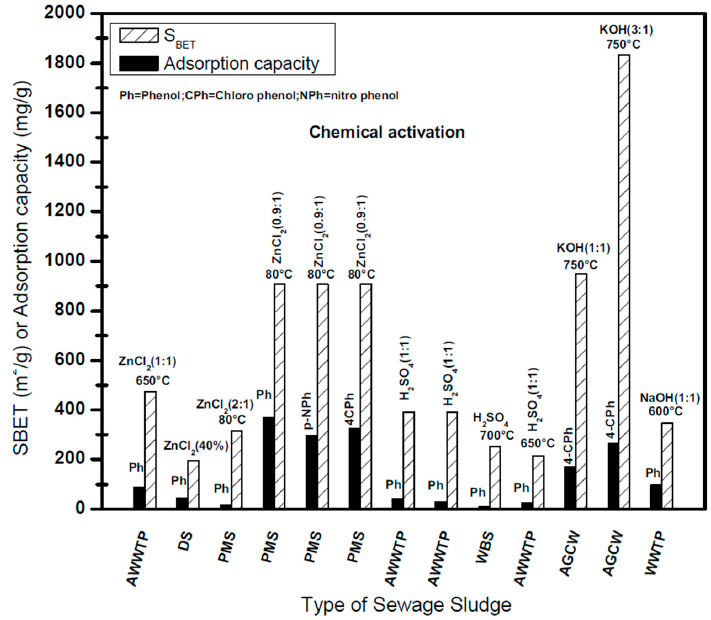
Figure 4. Achieved SBET in relation to uptake for phenolic compounds for chemically activted SBAC.